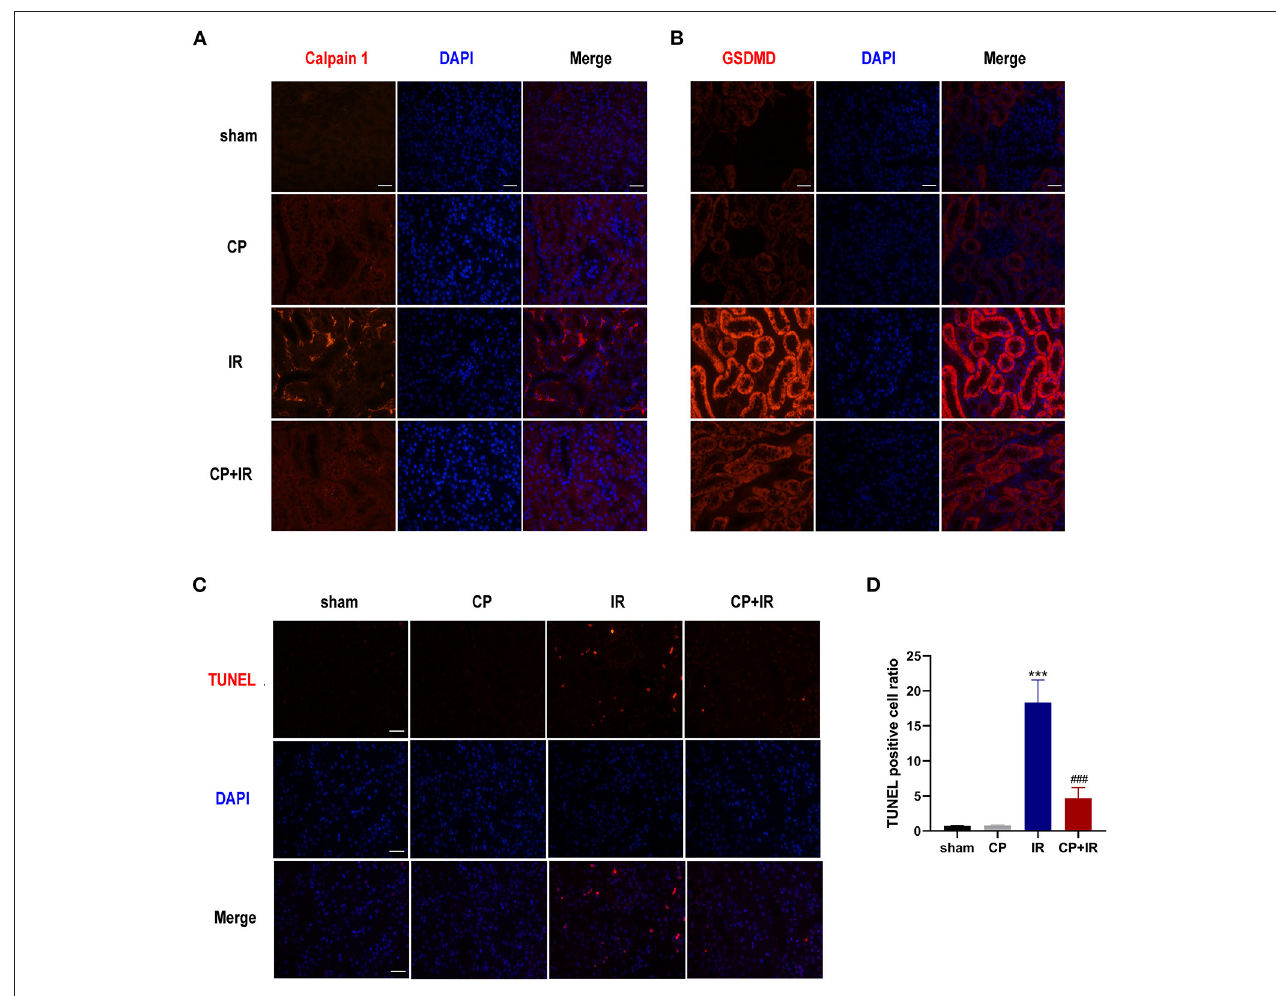
FIGURE 4 | Calpeptin inhibits Calpain 1 activation and GSDMD cleavage in the tubules of IR mice, reduces cells apoptosis as well. (A,B) Representative immunofluorescence micrographs from mice kidneys of different groups stained Calpain 1 and GSDMD. × 400, bar = 50 µ m. (C) Representative TUNEL staining micrographs in the mice kidneys of different groups. × 400, bar = 50 µ m. (D) Quantitative determination of apoptosis cells amount. All Values were presented as mean ± SEM ( n = 3). *** p < 0.001 vs. sham group; ### p < 0.001 vs. IR group. CP, calpeptin; IR,